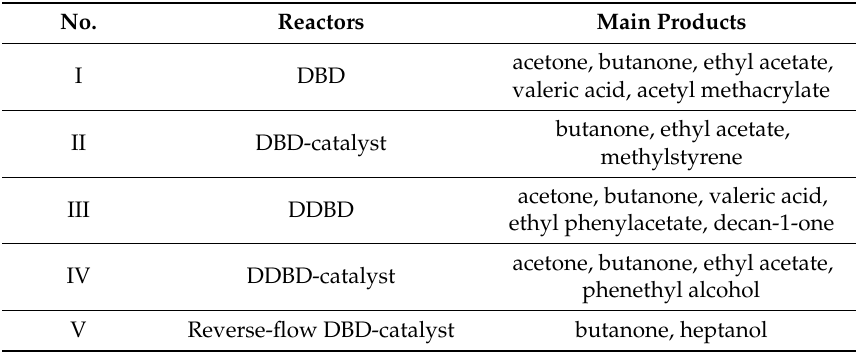
Table 3. Main products in di ff erent reactors. DBD, dielectric barrier discharge; DDBD, double dielectric barrier